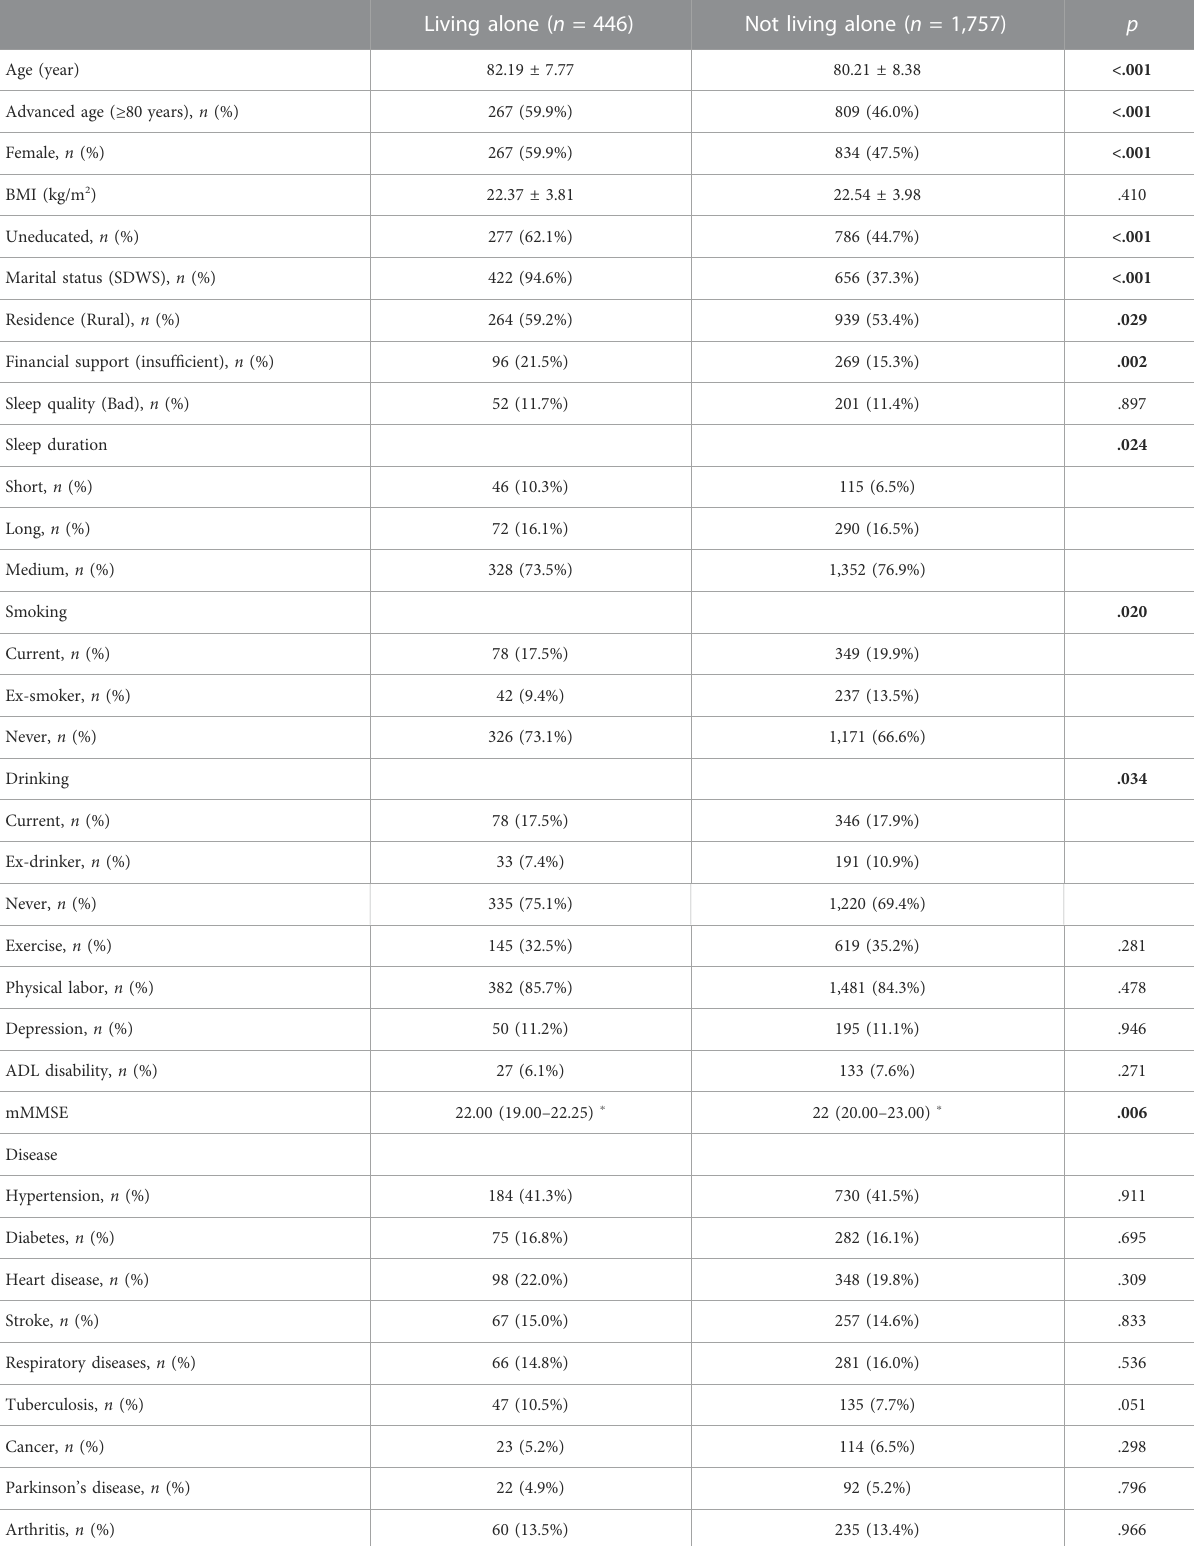
TABLE 1 Baseline characteristics by living arrangements at 2014